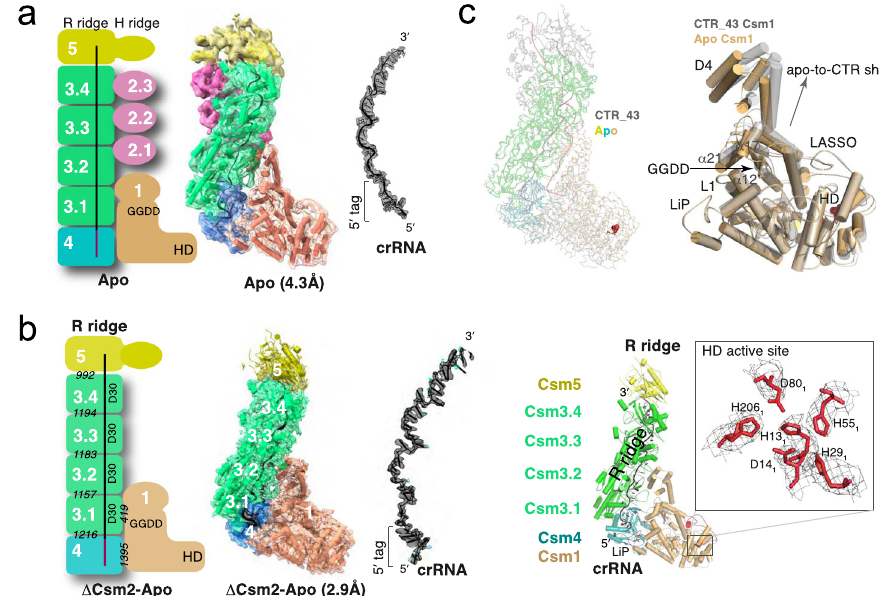
Fig. 4 Structures of apo LlCsm complexes lacking a bound target RNA. Numbers in white indicate names of the subunit where N or N.m represent CsmN (or the mth CsmN). Key secondary elements are labeled. The crRNA is shown in black. a Schematic representation, electron potential density, and cartoon representation of the LlCsm apo complex with stoichiometry 1 1 2 3 3 4 4 1 5 1 crRNA 1 Target 0 determined as a subpopulation when incubated with DTR. b Schematic representation, electron potential density, and cartoon representation of the re fi ned LlCsm apo complex with stoichiometry 1 1 2 0 3 4 4 1 5 1 crRNA 1 Target 0 determined when incubated with no target RNA. Italicized numbers in black indicate the buried solvent-accessible surface of the corresponding subunits in Å 2 . The boxed image shows a close-up view of well-placed catalytic HD residues with electron potential density. The putative catalytic residues His13, Asp14, Asp80, and His206 form a permuted HD motif and are strongly conserved. c Ribbon representation of apo LlCsm complex (at 2.9Å and colored) overlaid with LlCsm CTR-43 complex (gray) using their Csm3 subunits. The HD residues are highlighted in red. The cartoon representation depicts an upward shift of Csm1 D4 domain upon binding to CTR wherein alpha-helices α 12, α 17, and α 21 follow along. Note the minimal shifts among LASSO, LiP, and L1